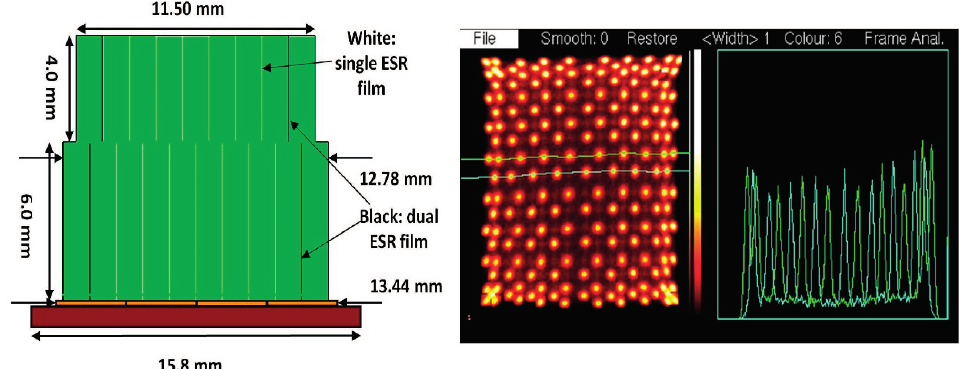
Figure 8. Detector with SensL B-series SiPM and LYSO crystal block with 81 crystals in the upper layer and 100 in the lower layer and the response pattern with profiles through rows of crystals showing that they are well